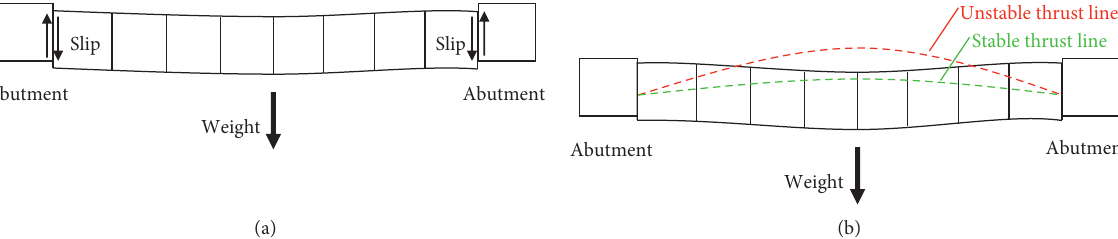
Figure 3: The failure modes of the loosened zone. (a) The slip failure; (b) The snap